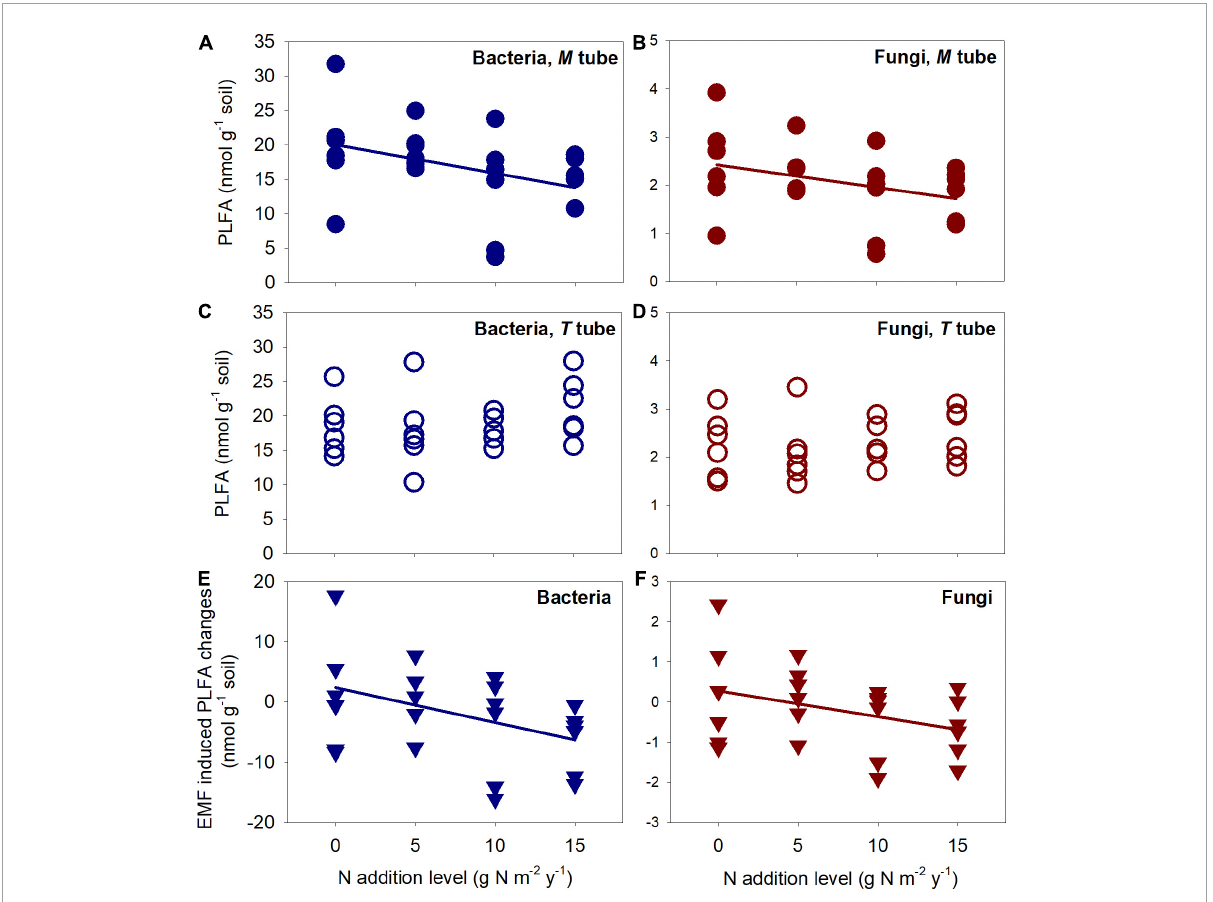
FIGURE4 Response of fungal and bacterial PLFAs, as well as ectomycorrhizal fungi (EMF) induced PLFA changes to N fertilization levels. The PLFAs were extracted from soil at 0–10 cm. The bacterial and fungal PLFA negatively and significantly (or marginally significantly) responded to increased N fertilization only in the M tubes ( r 2 = 0.15, P = 0.05 for bacteria and r 2 = 0.12, P = 0.10 for fungi) (A,B) , but not in the T tubes ( P = 0.31 for bacteria and P = 0.42 for fungi) (C,D) . The EMF induced PLFA changes ( M tube— T tube) also negatively and significantly (or marginally significantly) responded to increased N fertilization for both bacteria ( r 2 = 0.17, P = 0.04) and fungi ( r 2 = 0.13, P = 0.08) (E,F) .